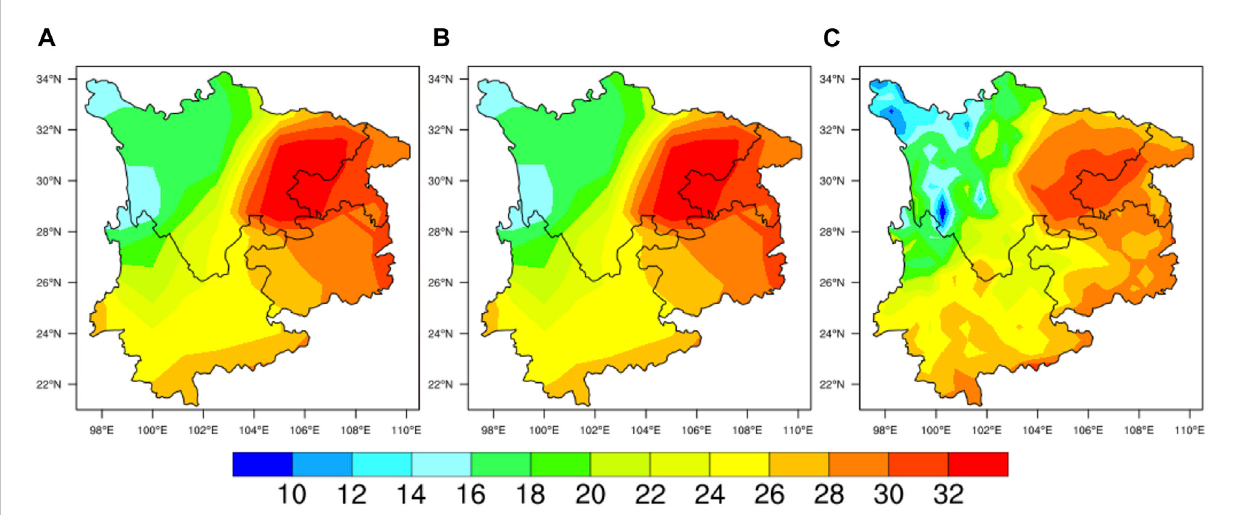
FIGURE 5 The 2-m air maximum temperature (T max ) results for southwest China from 1992 to 2013 in the boreal summer (JJA): (A) control modeling results without AHR; (B) modeling results with AHR; (C) CRU data results (unit: °